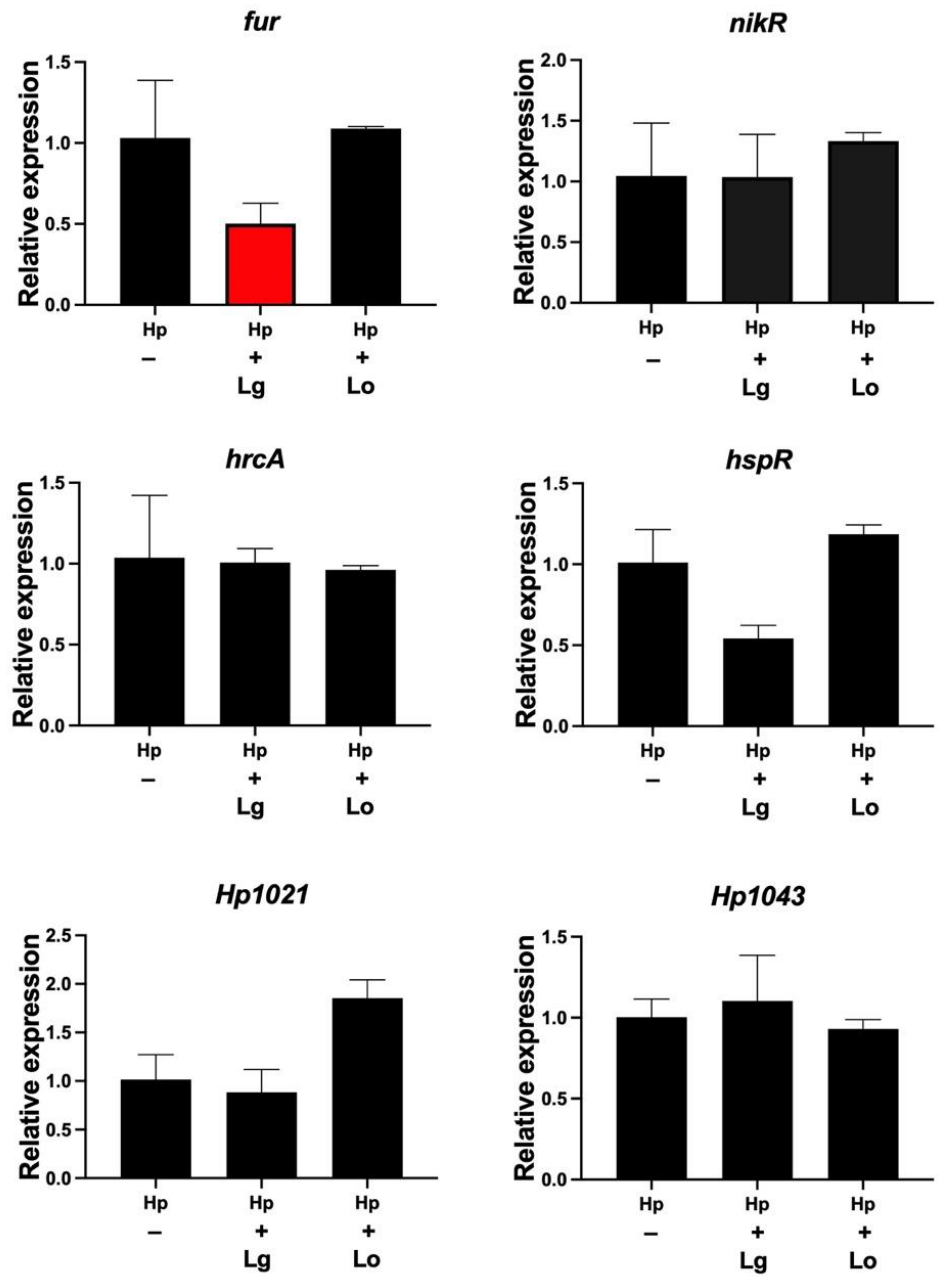
Figure 5. L. gasseri CM affects fur gene expression. Gene expression of H. pylori (Hp) transcription factors analyzed by qPCR after incubation for 2 h in CM from L. gasseri or L. oris (Lo). Target mRNA levels were normalized to those of the housekeeping gene gyrB . Gene expression levels in the control were set to 1. Data are presented as the means and standard deviation of duplicate samples and are average of three independent experiments.